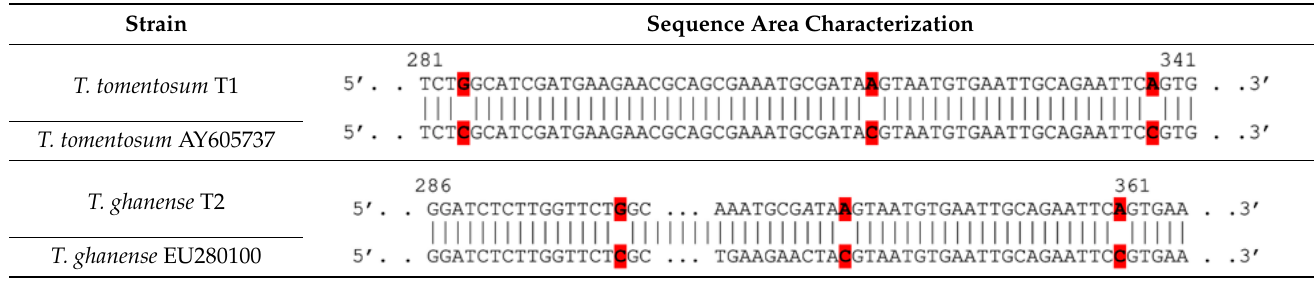
Table 2. Characterization of Trichoderma strains according to ITS region differences.